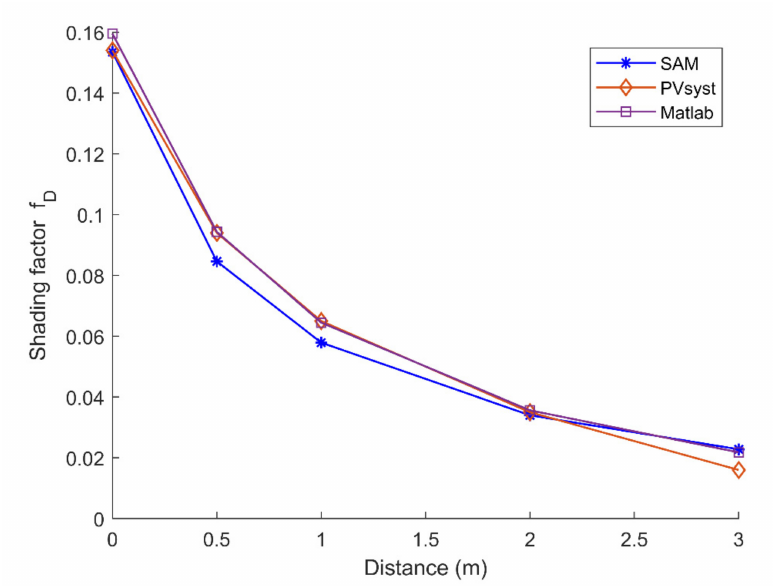
Figure 22. Diffuse shading factor for a module shaded by a block positioned on the east side of the module, assuming different distances of